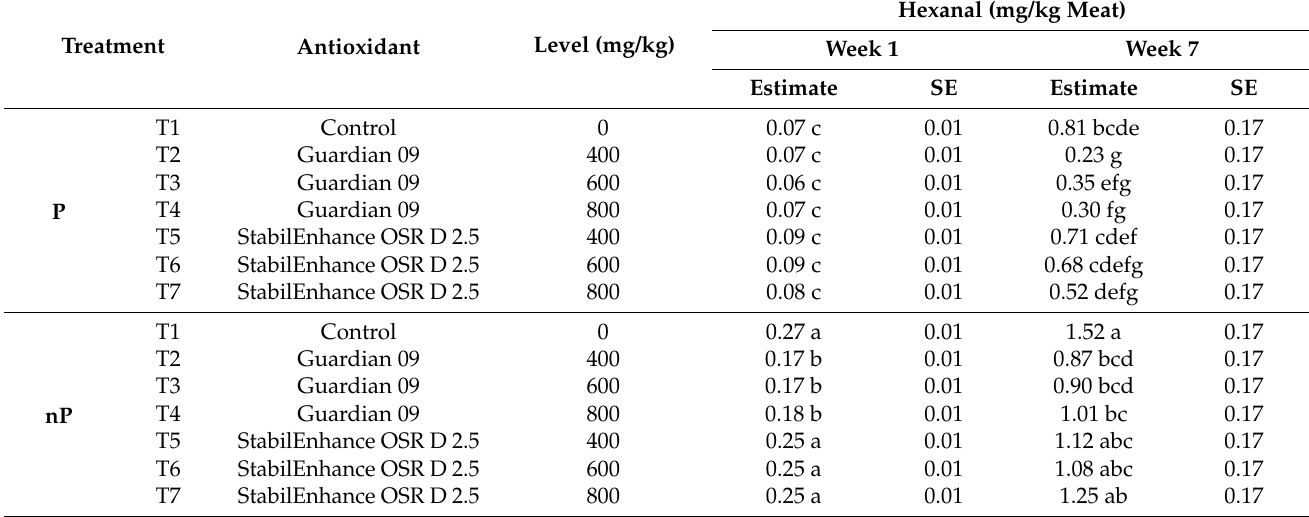
Table 2. Hexanal content (mg/kg meat) in chicken fillet with or without phosphate. Estimate indicates the mean hexanal content for triplicate determinations. Means with different letters within each week indicate significant difference ( p ≤ 0.05) between treatments. P = samples containing phosphate, nP = samples without